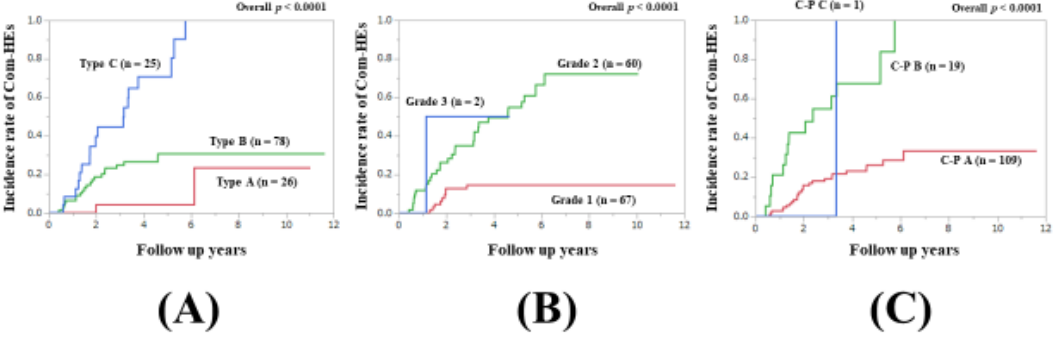
Figure 3. Cumulative incidence rates of composite hepatic events in patients less than 67 years (median value in our cohort, n = 129). ( A ) Serum Zn level grading system. ( B ) ALBI grading system. ( C ) Child–Pugh classification.